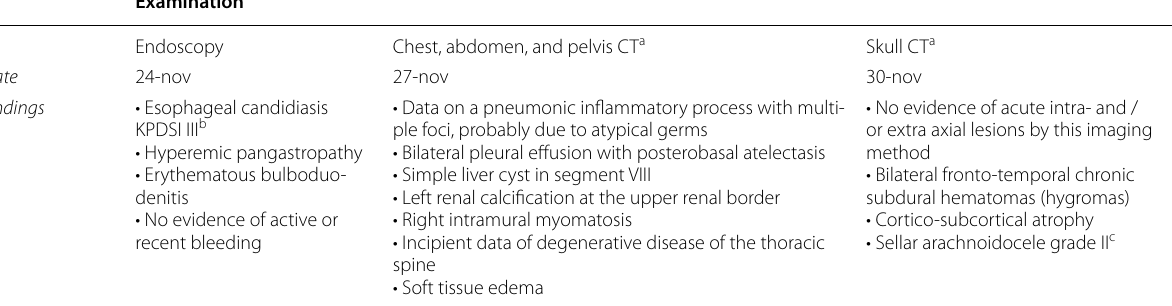
a CT Computed tomography b Kodsi Classification of candida esophagitis c Empty sella syndrome